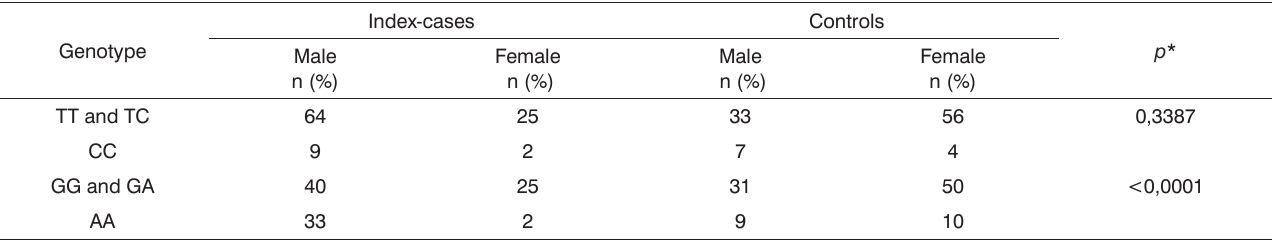
Table 5. Gender distribution of index cases and controls relative to the genotypes for T102C and -1438G/A polymorphisms of the 5-HTR2A